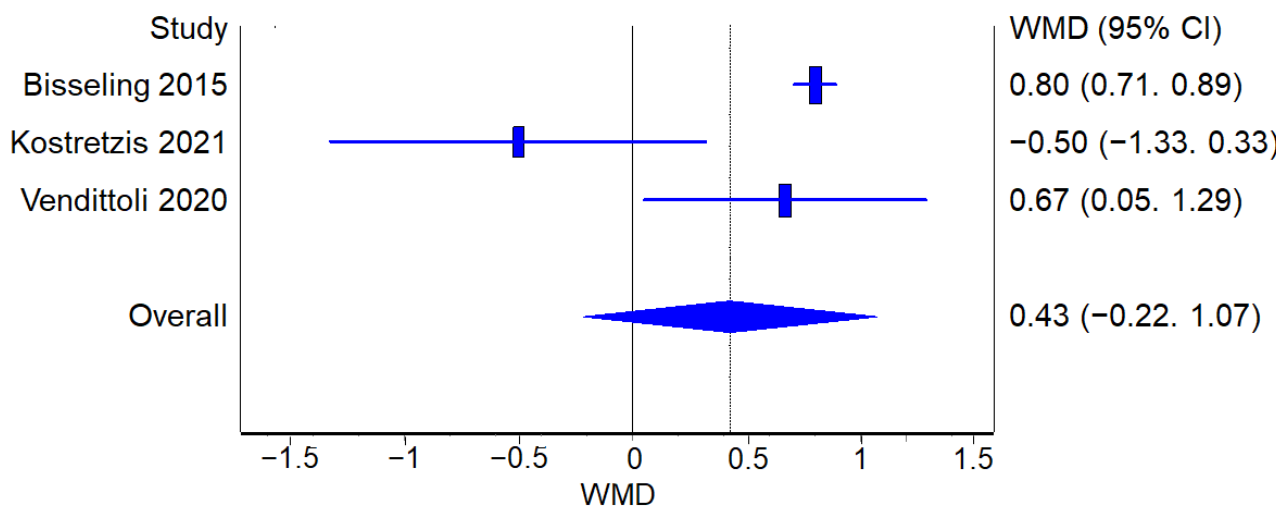
Figure 12. Chromium Levels: Forest plot of the individual studies and pooled mean difference for blood chromium levels, including a 95% confidence interval. The size of the squares shows the weight of the study. [17 – 19,21,27 – 31].